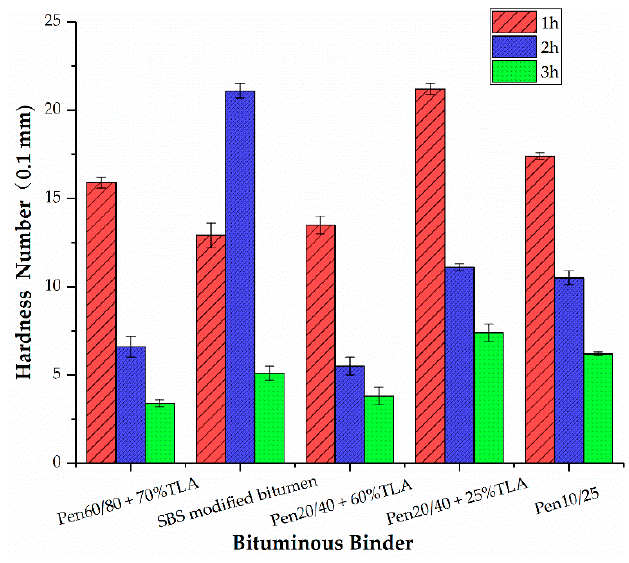
Figure 2. E ff ect of bituminous binder on hardness number for GMA. Figure 2. Effect of bituminous binder on hardness number for GMA. Figure 2. Effect of bituminous binder on hardness number for GMA.